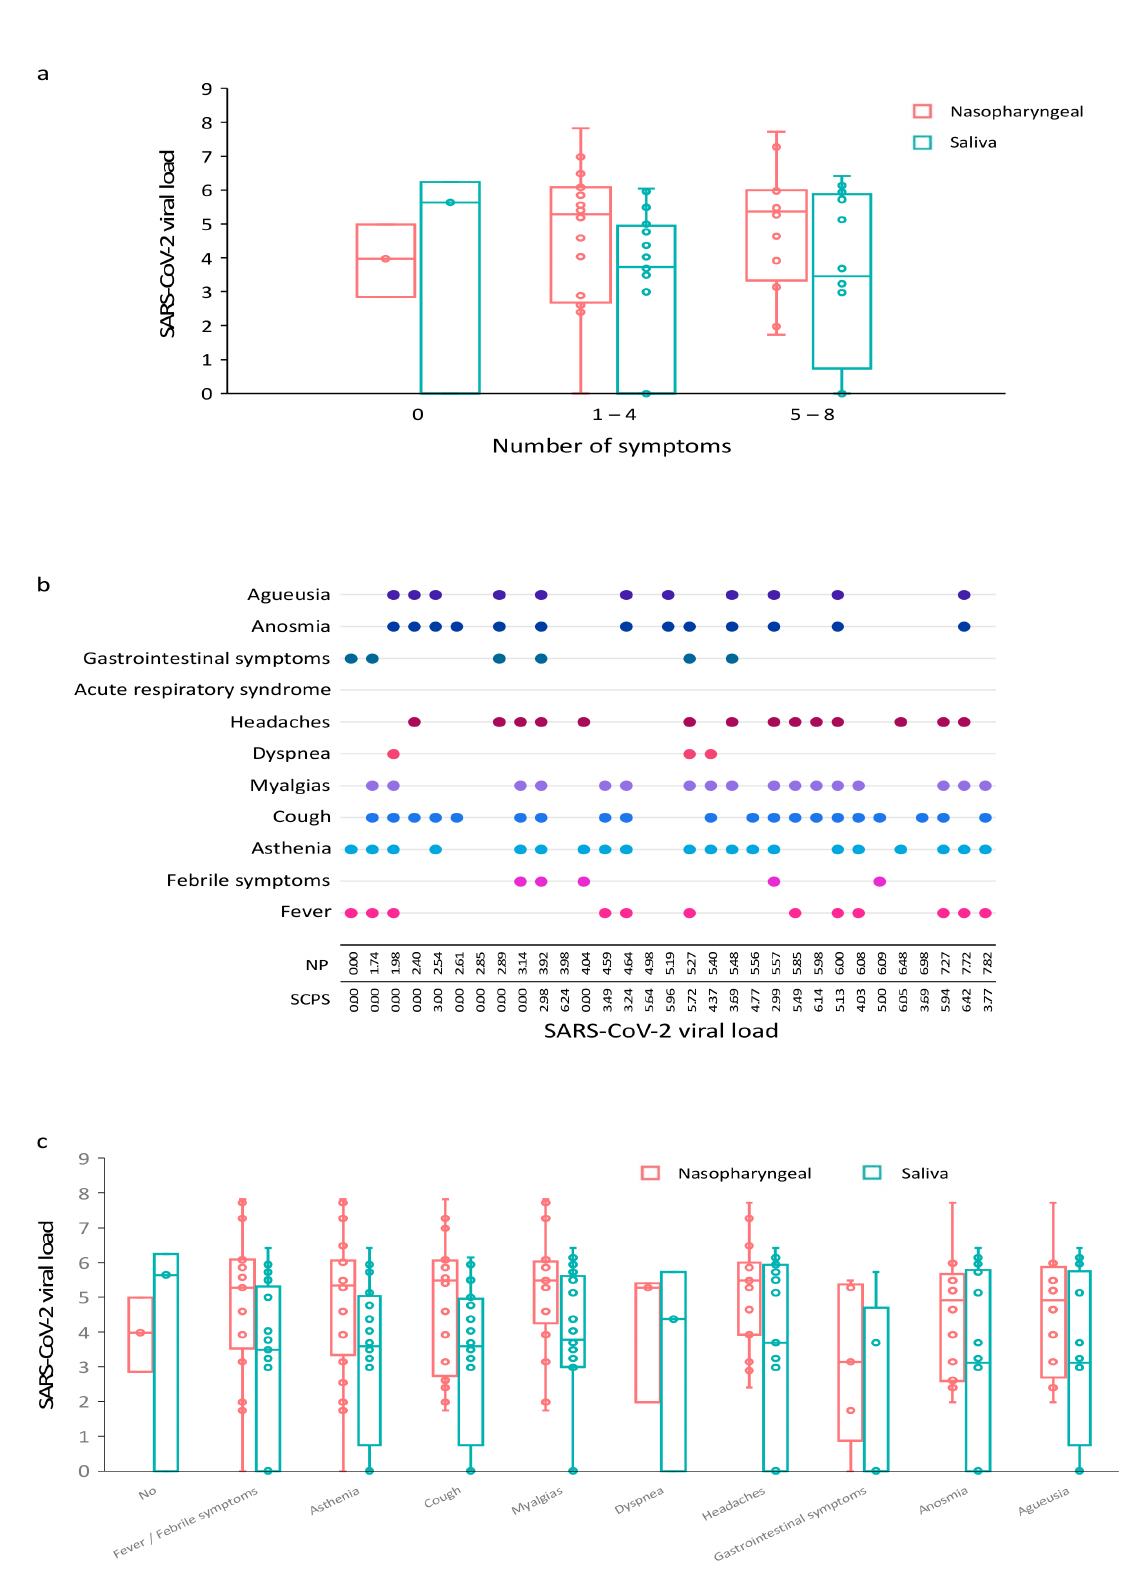
Figure 2. Correlation between SARS-CoV-2 viral load and COVID-19 symptoms. ( a ) SARS-CoV-2 load according to the number of clinical symptoms; ( b ) Symptoms according to the SARS-CoV-2 load for each subject; ( c ) SARS-CoV-2 load according to the type of clinical symptoms. NP, nasopharyngeal; SCPS, self-collected pure